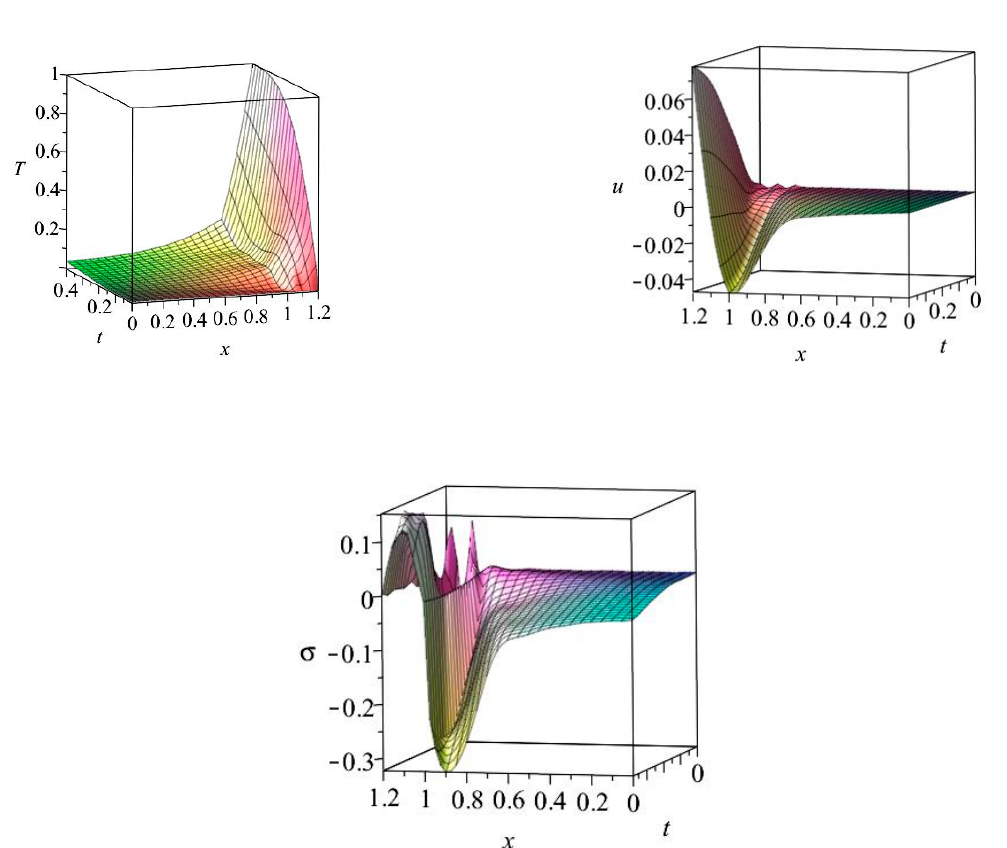
Figure 5. The thermal conductivity coefficient increased by four times for layer 2, the thickness of the layers remained unchanged.